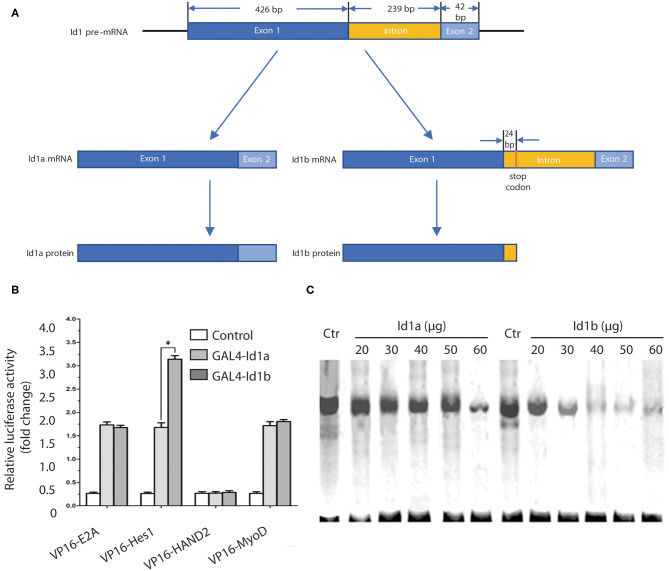
The affinity of Id1b for Hes1 is more potent than that of Id1a. (A) The Id1 coding sequence consists of two exons: the 5′ exon of 426 bp, including the HLH region, and the 3′ exon of 42 bp. These exons are separated by an intron of 239 bp. From the sequence of the introns, Id1b is generated by skipping the 5′ splice donor signal following the first exon. This skipping adds 24 bp to the translatable sequence. (B) Mammalian two-hybrid analysis of the ability of Id1a or Id1b to dimerize with bHLH transcription factors. Cells were transfected with the indicated plasmids and assayed for luciferase production at 48 h post-transfection. The value is normalized to Renilla luciferase activity. All error bars are mean ± S.D., n = 3. *P < 0.05, compared with GAL4-Id1a. (C) Electrophoretic mobility shift assays to identify differential Id1a and Id1b protein interaction. The assays were performed with increasing amounts (20, 30, 40, 50, 60 μg) of cell extracts from Id1a- or Id1b-transfected cells, then mixed with a constant amount cell extracts from Hes1-transfected cells. The same amount of cell extracts from untransfected cells (Ctr) was used as a negative control.